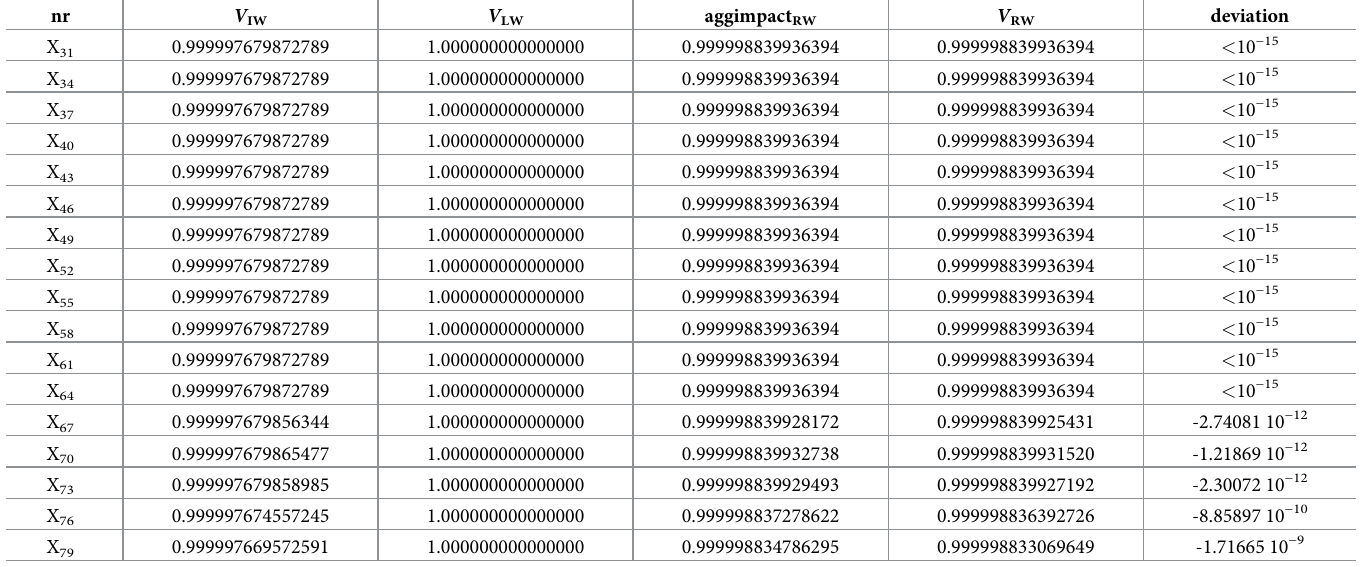
Table 8. Equilibrium analysis results for the